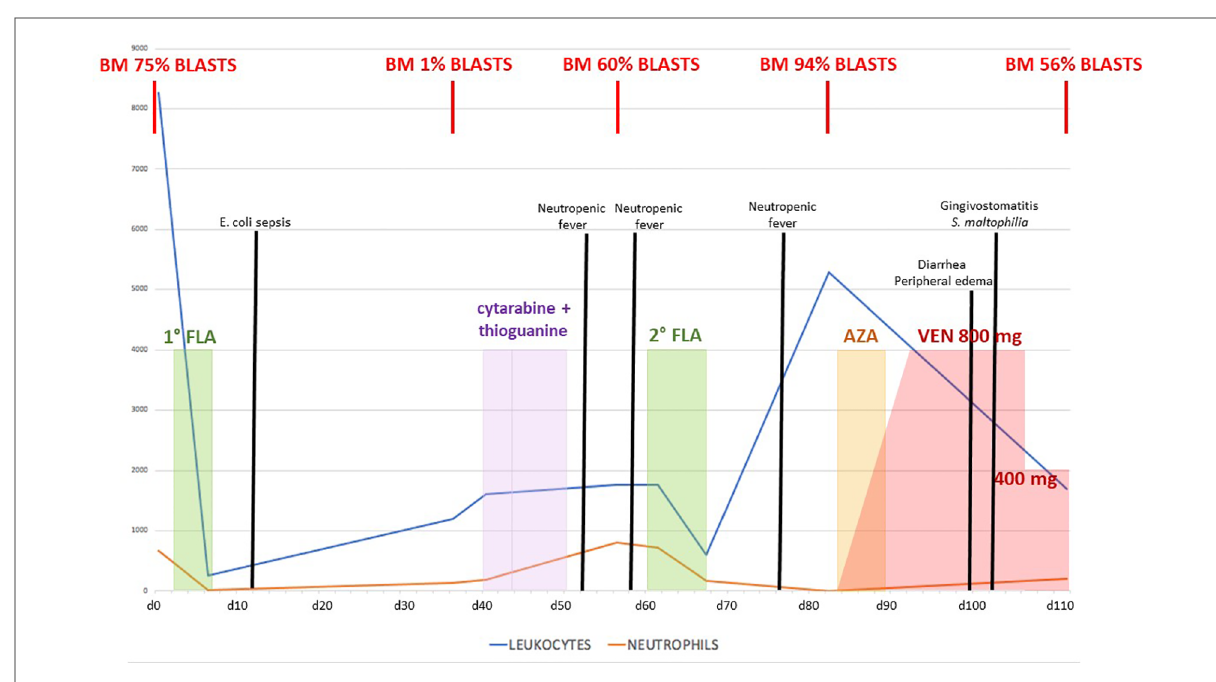
FIGURE 1 Graph presentation of chemotherapy treatment with blast count trend and clinical course